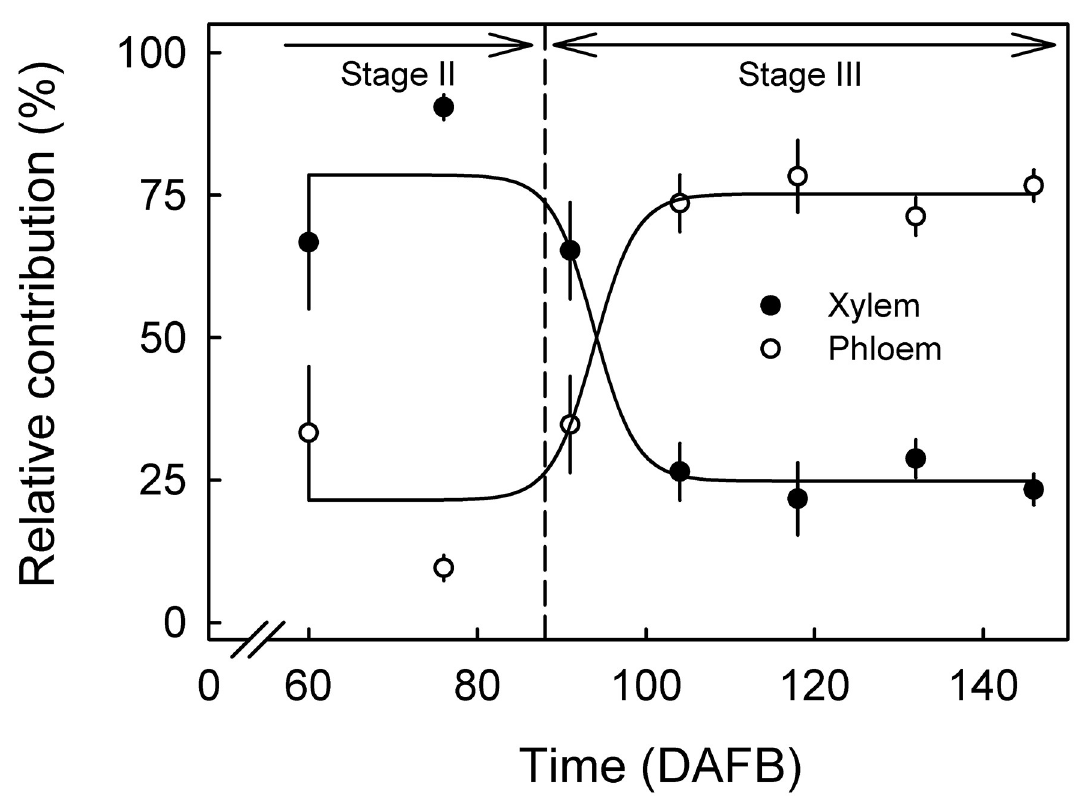
Fig 7. Relative contributions of xylem and phloem sap inflows to total sap inflow to fruit of developing European plums. Total inflow (100%) was calculated as the sum of the xylem and phloem inflows. Data represent means ± SE.